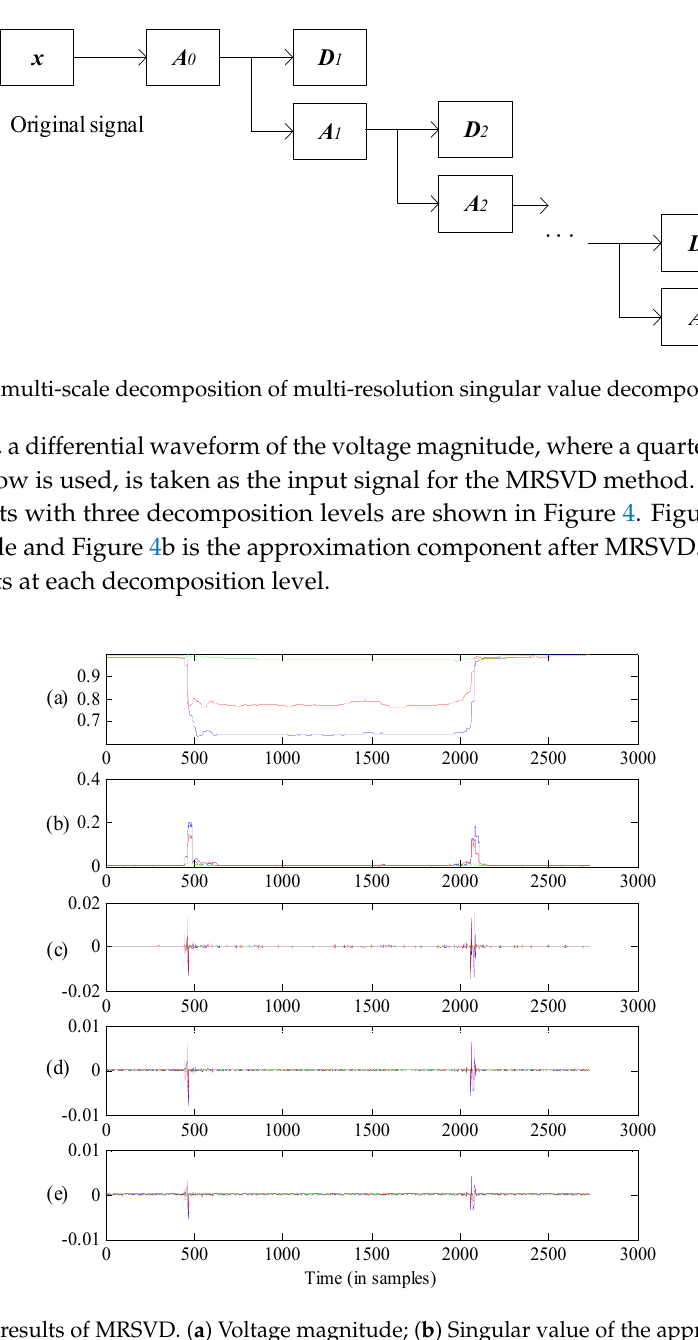
Figure 3. The multi-scale decomposition of multi-resolution singular value decomposition (MRSVD).